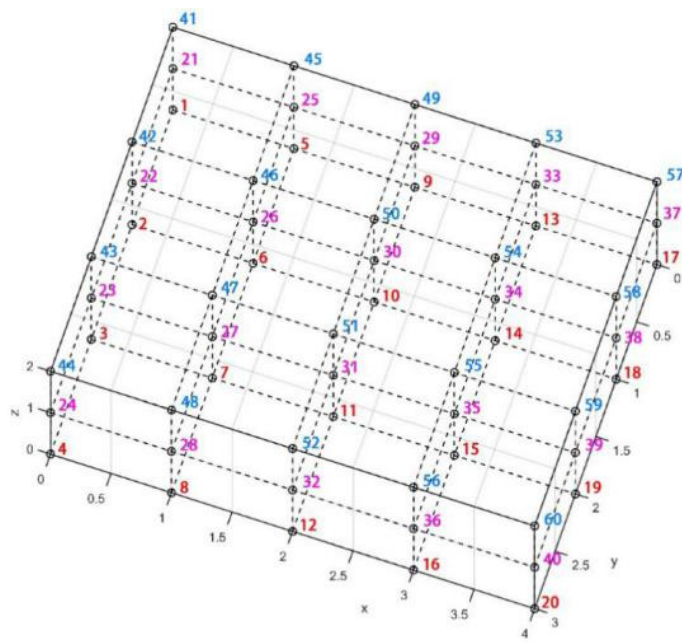
Figure 3. Model coding schematic diagram.